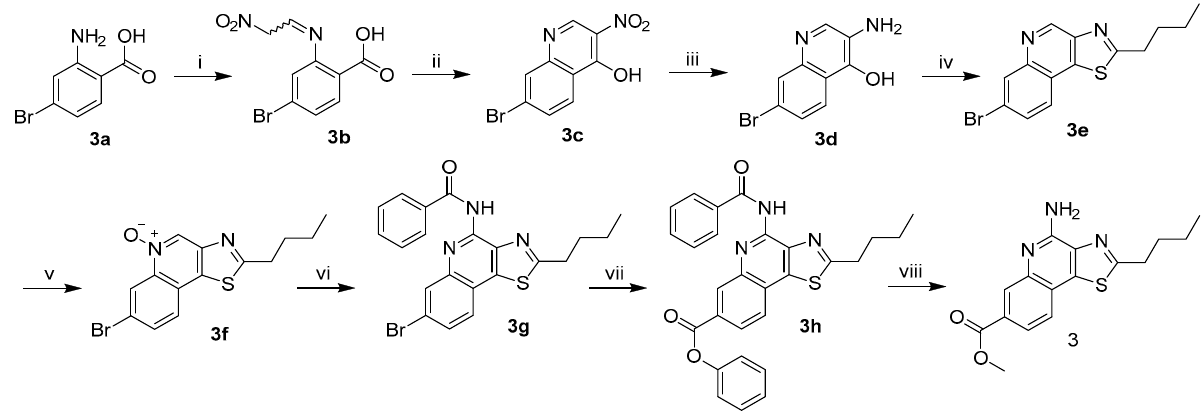
Scheme 1. Reagents and conditions: (i) methazoic acid, H 2 O-dioxane, 40 °C to rt, 15 h, 78%; (ii) sodium acetate, Ac 2 O, 130 °C, 2 h, 57%; (iii) sodium dithionite, DMF, rt, 15 h, 46%; (iv) (a) C 4 H 9 COCl, pyridine, 50 °C, 1 h, (b) P 4 S 10 , 110 °C, 15 h,